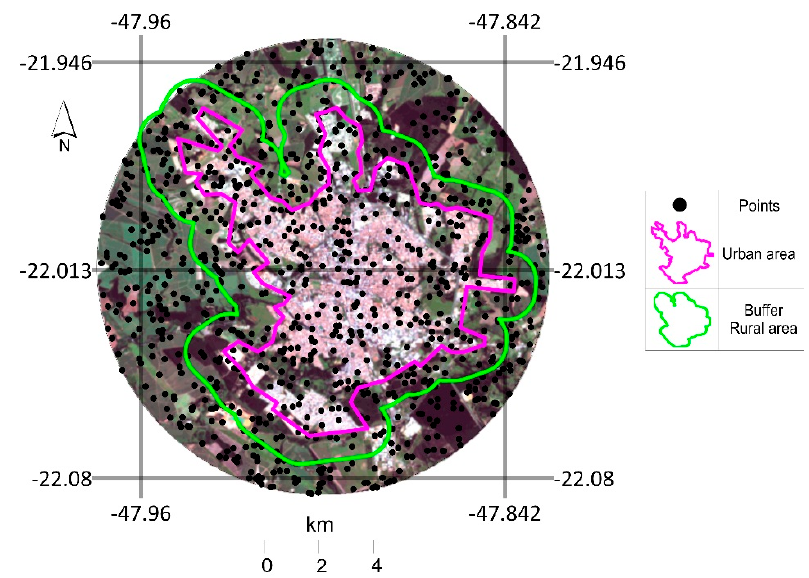
Figure 3. Random measuring points within the urban boundary and the rural buffer of São Carlos.